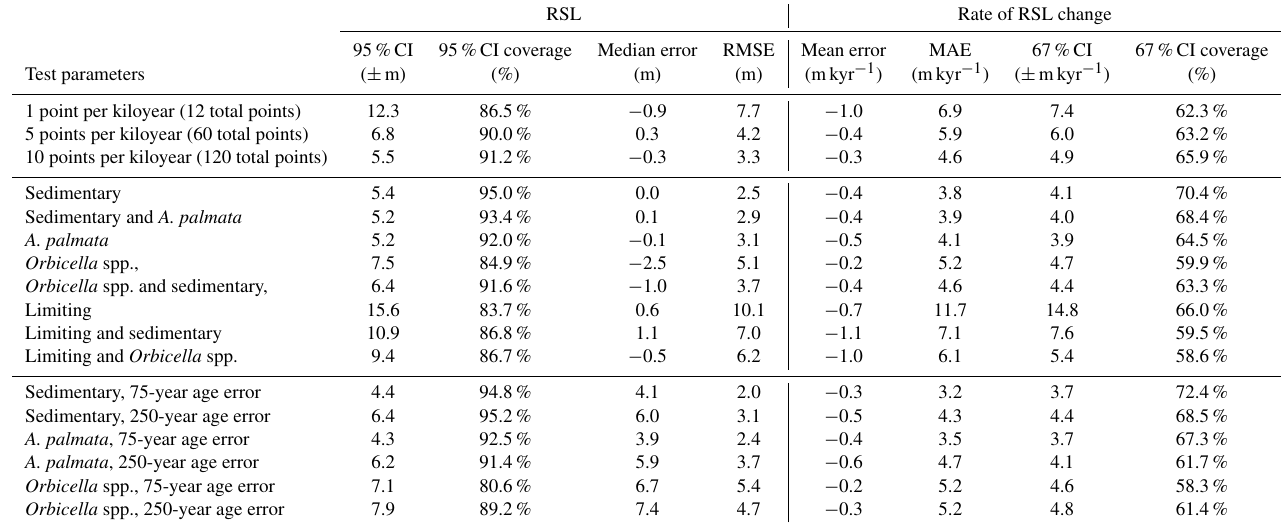
Table D6. Sensitivity test results for sea-level curve 2 (SL2).